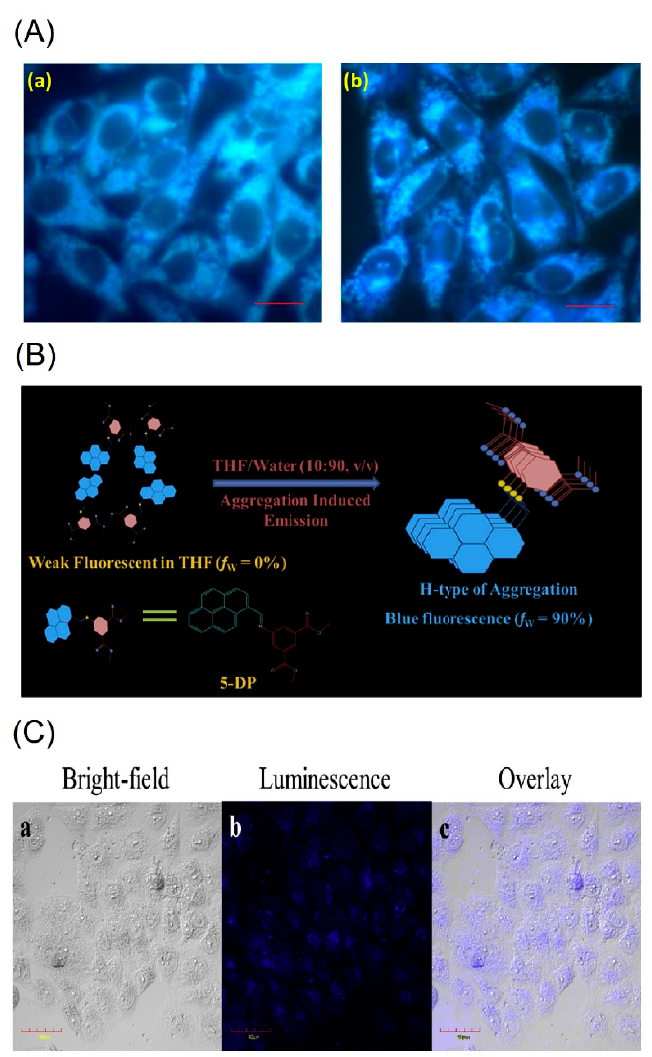
Figure 17. ( A ) Fluorescent microscopic observation of ( a ) A549 & ( b ) MCF-7 cells treated with the C27 (represented as “ PS ” in the original report) aggregates. Scale bar represents 20 µm (Repro- duced with the permission from Ref. [95]). ( B ) Schematic representation of the formation of ture through H -Type of aggregation. ( C ) Confocal imaging of HeLa cells incubated with 40 µg mL − 1 of C28 -P123 nanoaggregates for 4 h at 37 °C, scale bar 40 µm ( B , C are reproduced with the